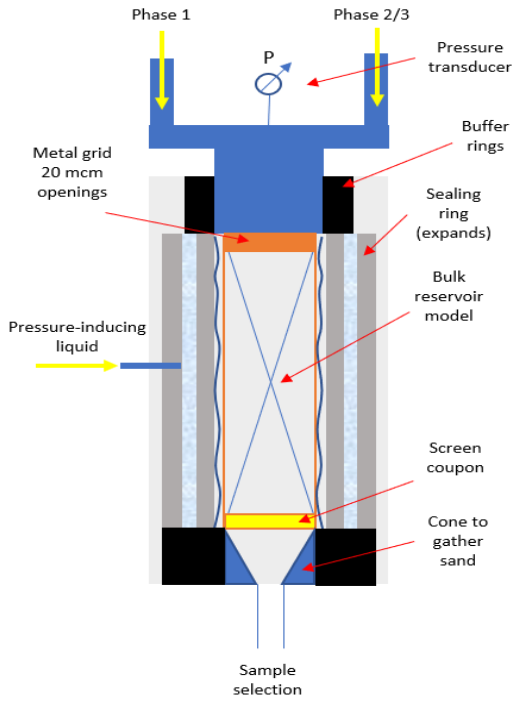
Figure 7. Coreholder scheme.